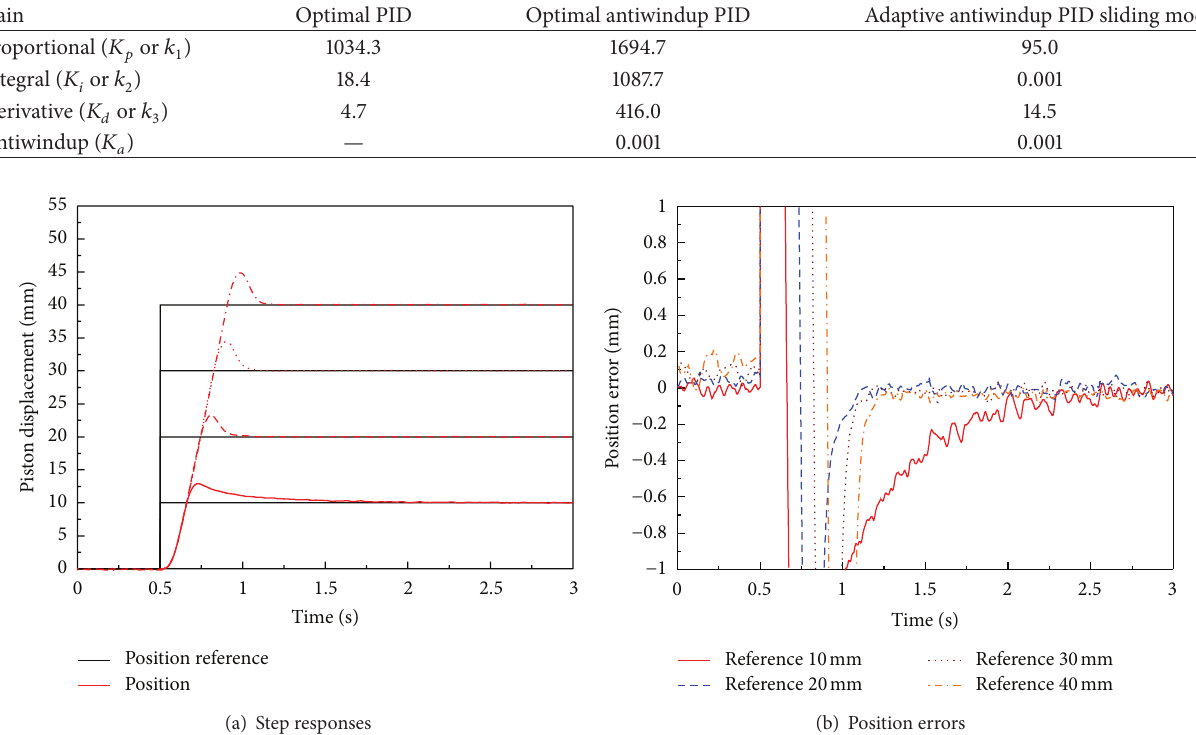
Figure 11: Performances of optimal PID position control system for EHA without load disturbance (only mass load is